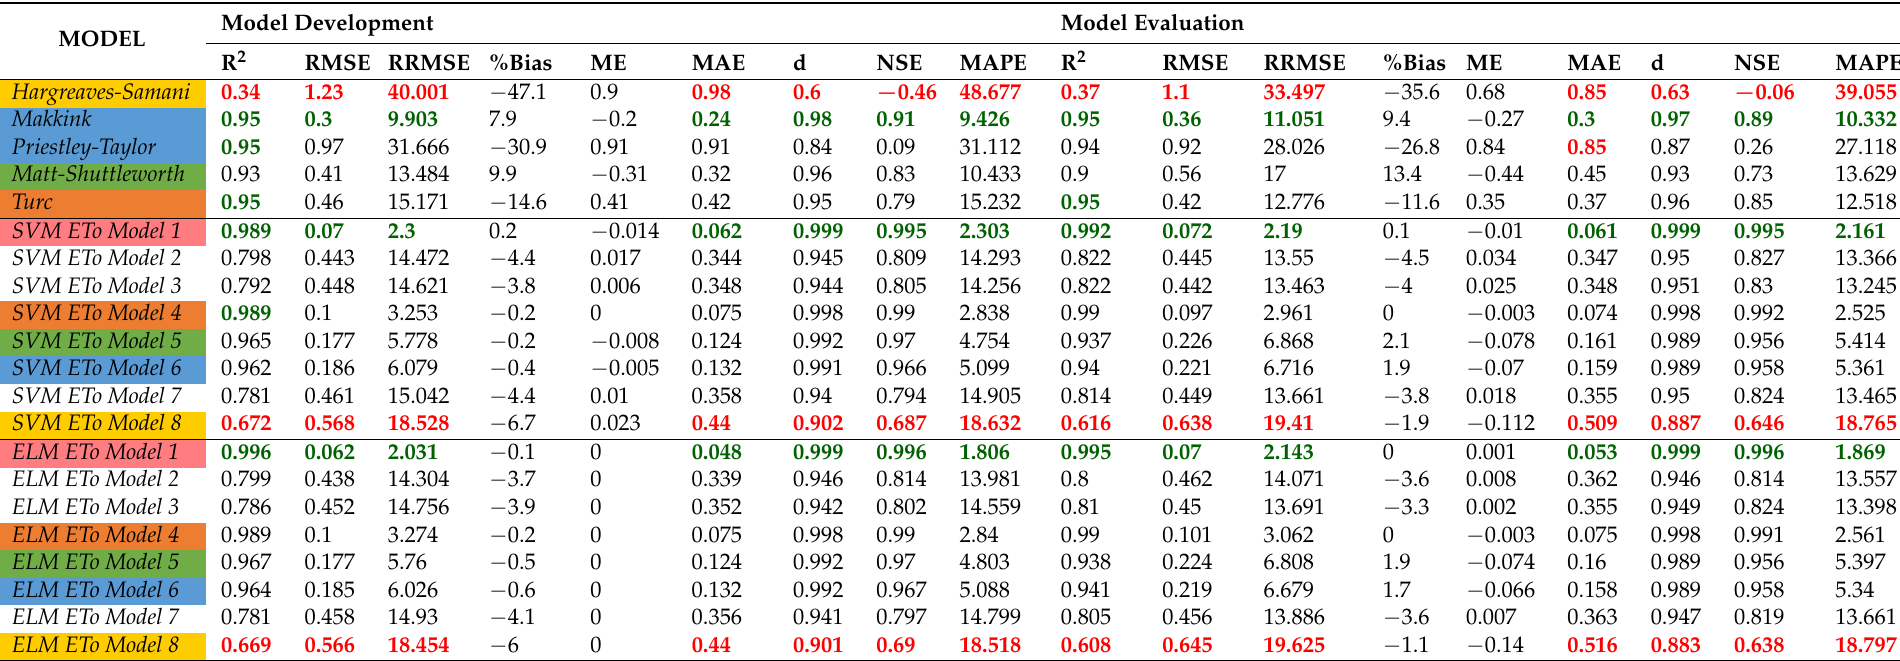
Table 11. Statistical values of empirical and machine learning models in estimating daily ETo at Tanay Station